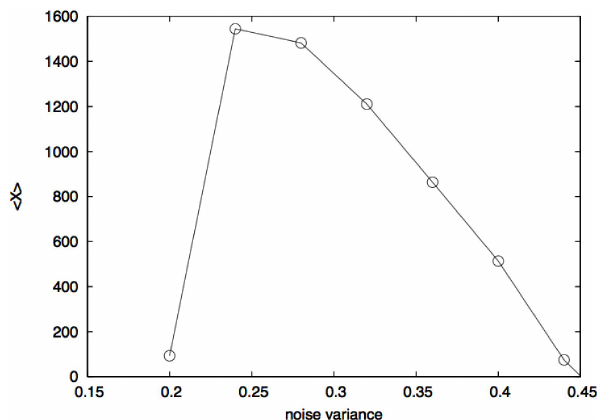
Fig. 13. The quantity h D x i as a function of σ .